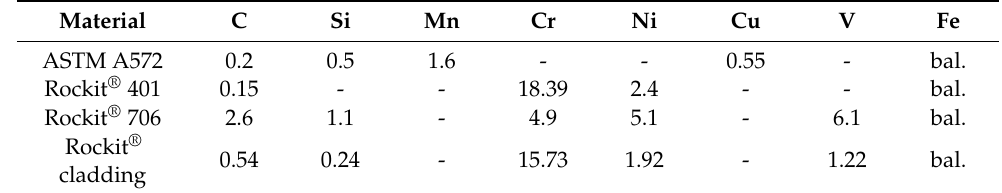
Table 1. Chemical composition of cladding and base material in wt.% ± 0.005; N < 0.05; P & S <